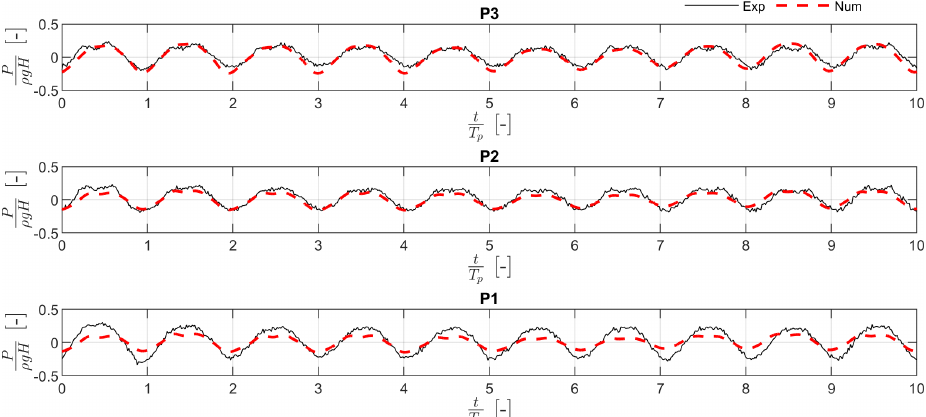
Figure 7. Comparison between the pressure measured in the experimental campaign by the three transducers located on the rear wall and that estimated by the numerical model. The data refer to a wave with kd = 0.86.